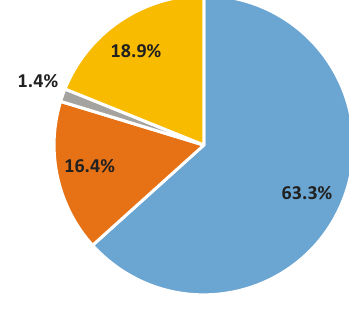
Figure 4: Bene fi ciaries by sex in 2015 – 2019. Source: NNLE Rural Development